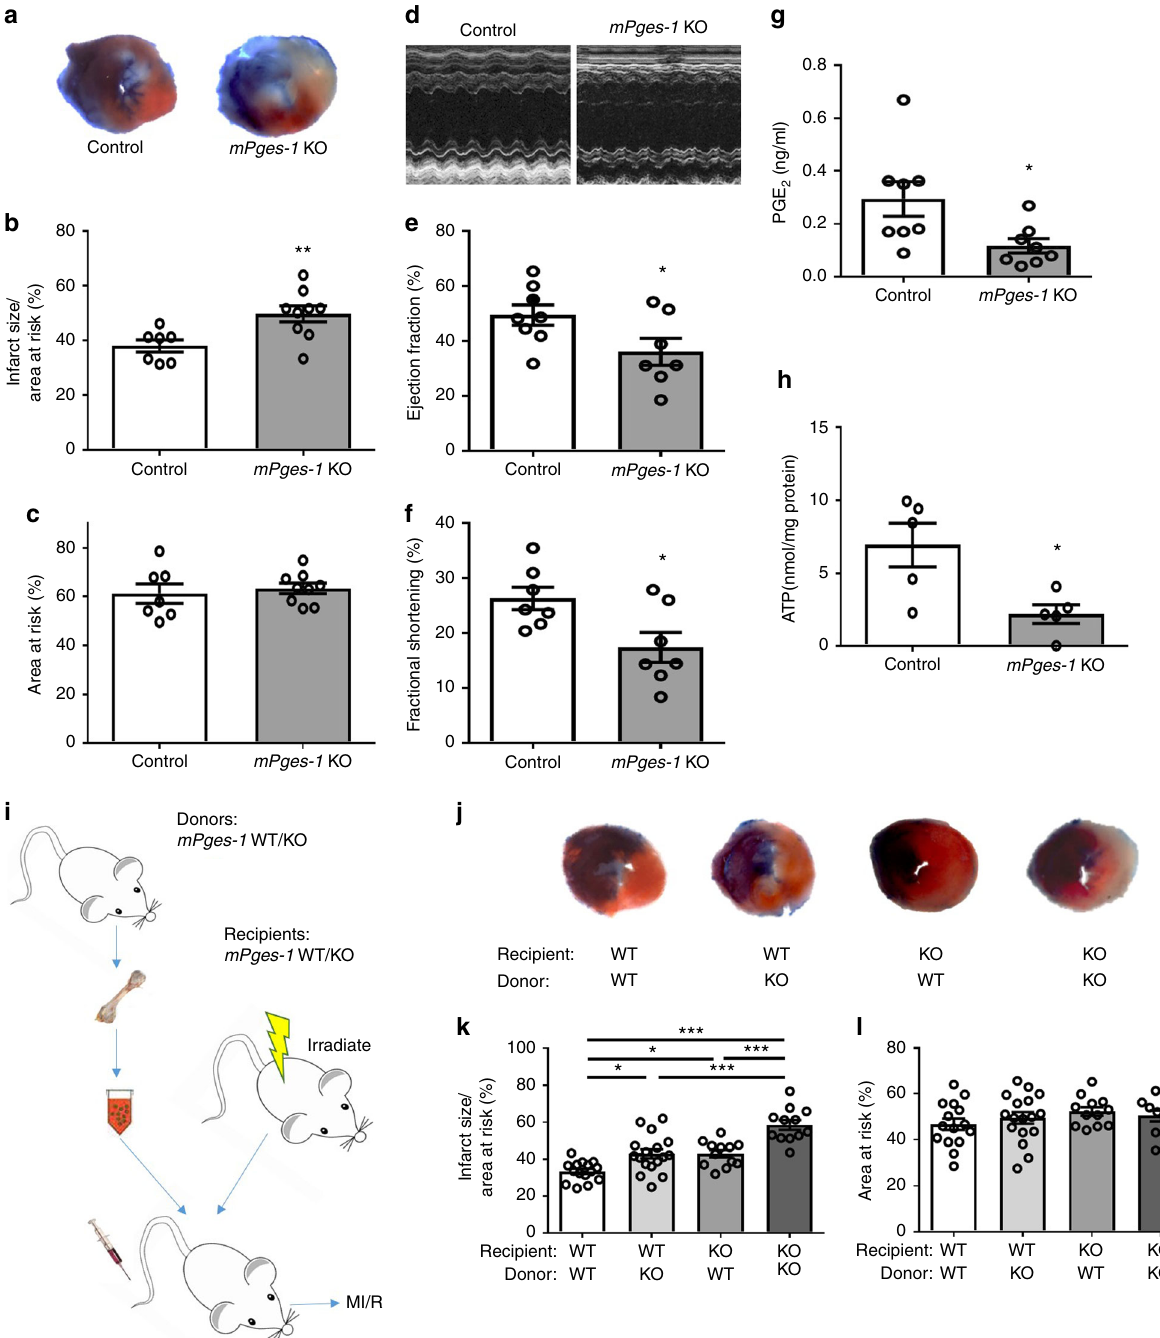
Fig. 2 Impact of mPges-1 deletion on MI/R injury. Mice were subjected to MI/R injury as detailed in the Methods. a Representative photographs of TTC stained sections from Evans blue perfused hearts. Infarct size ( b ) and AAR ( c ) were quanti fi ed for mPges-1 KO and control mice. Representative echocardiograph ( d ), ejection fraction (EF) ( e ), and fractional shortening (FS) ( f ) were shown. PGE 2 levels were compared ( g ). Cardiac levels of ATP post MI/R were measured ( h ). Unpaired Student ’ s t test ( b , c , n = 7, 9; e , n = 8, 7; f , n = 7, 7; g , n = 8, 8; h , n = 5). Bone marrow cells were transplanted reciprocally between mPges-1 WT and KO mice ( i ). The resulting chimeric mice underwent MI/R injury. Representative TTC staining was shown for each group ( j ). Infarct size ( k ) and AAR ( l ) were analyzed with use of one-way ANOVA and Tukey ’ s multiple comparison test ( n = 15, 17, 12, 12). Error bar indicates SEM NATURE COMMUNICATIONS| (2019) 10:1888